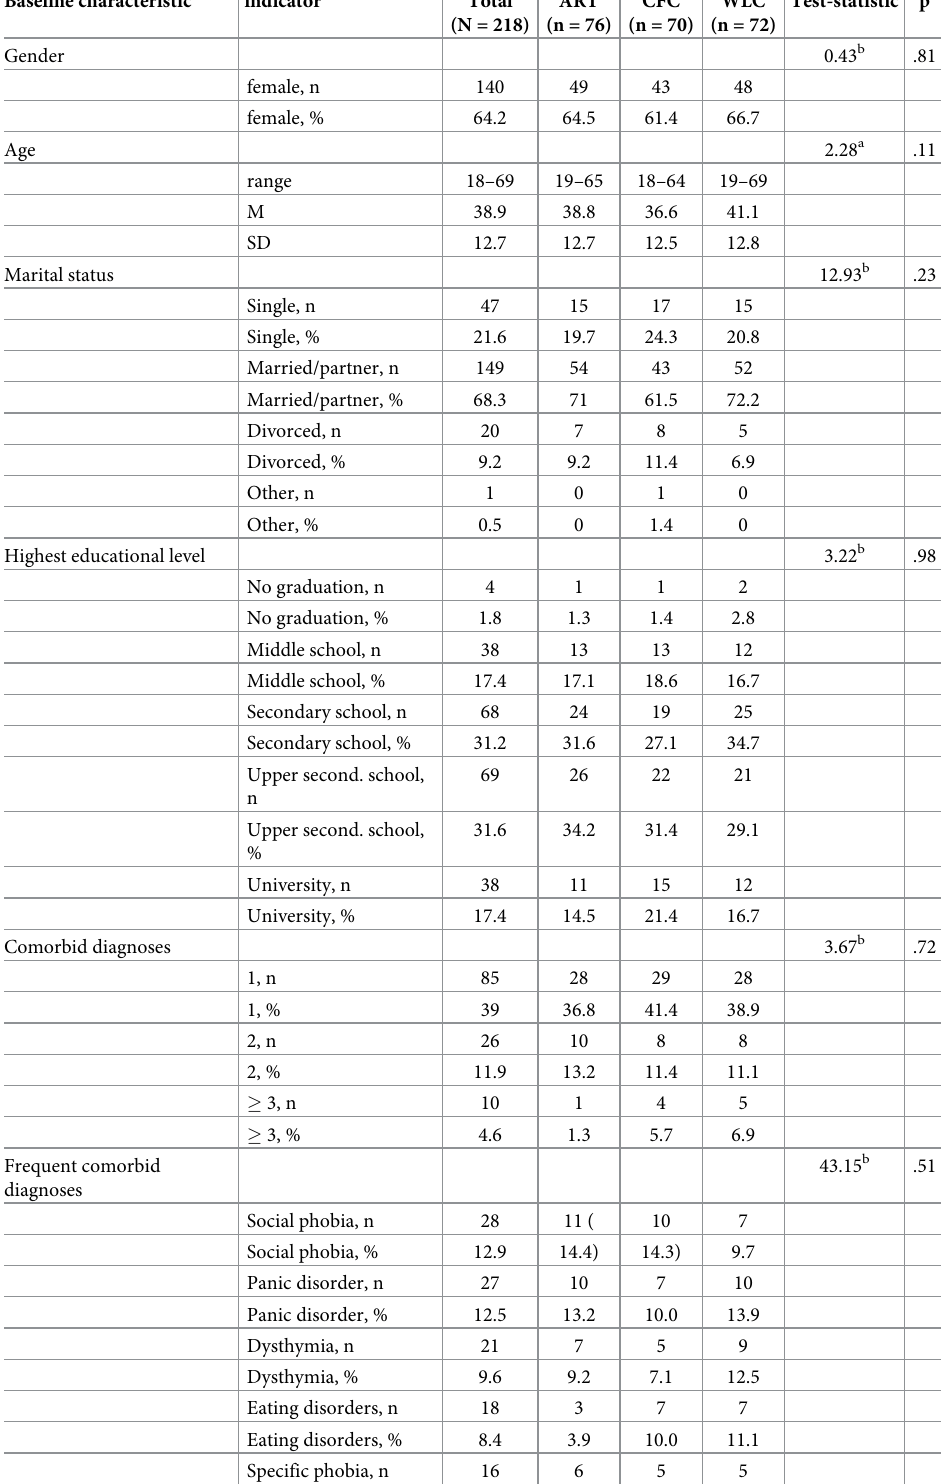
Table 1. Sociodemographic characteristics and comorbidity at